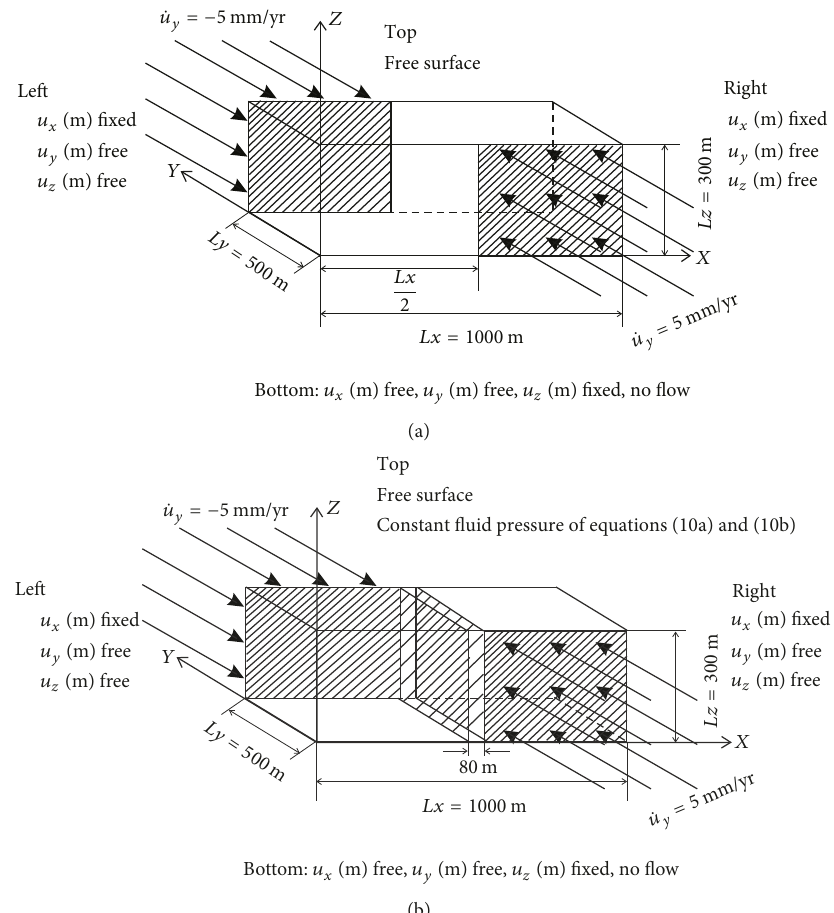
Figure 1: The two conceptual models: (a) is Model I and (b) is Model II. Two opposite velocity fields were applied to the two boundary faces (the shaded areas) to simulate the shear stress generated from nonuniform crust movement. The unit of the displacement, 𝑢 𝑥 , 𝑢 𝑦 , and 𝑢 𝑧 , is meter and that of the velocity ̇𝑢 𝑦 is mm per